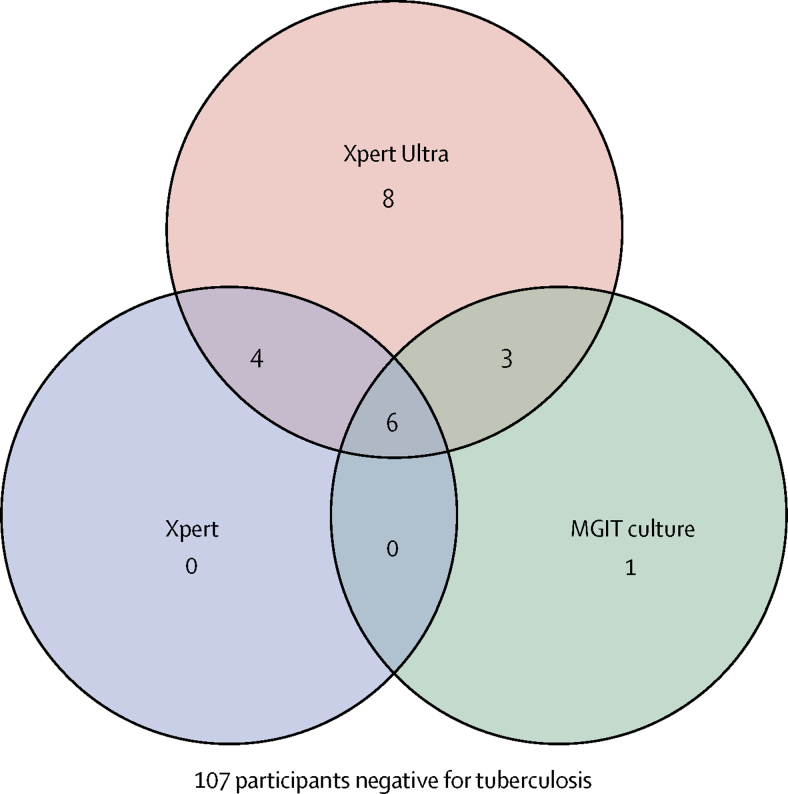
Venn diagram of overlap in tuberculous meningitis diagnosticsThe Venn diagram displays 22 participants with tuberculosis detected in CSF by each diagnostic test and the overlap between tests. Of eight participants positive by Xpert Ultra only, six had recently initiated HIV therapy, and all eight were negative by testing with cryptococcal antigen, India ink, Gram stain, culture, and multiplex PCR for 14 common meningitis pathogens. Xpert=Xpert MTB/RIF. MGIT=mycobacteria growth indicator tube. CSF=cerebrospinal fluid.